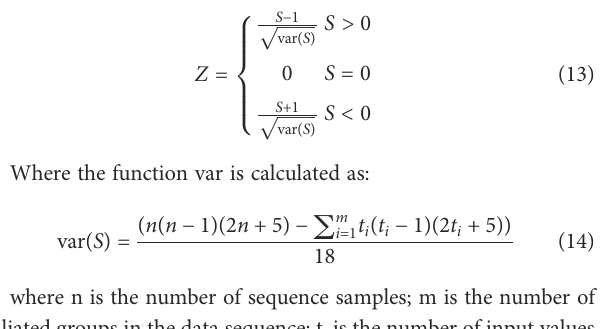
TABLE 1 The values of NDVI (i,min) , NDVI (i,max) , NDVI (i,min) and NDVI (i,max) and ϵ max of different vegetation